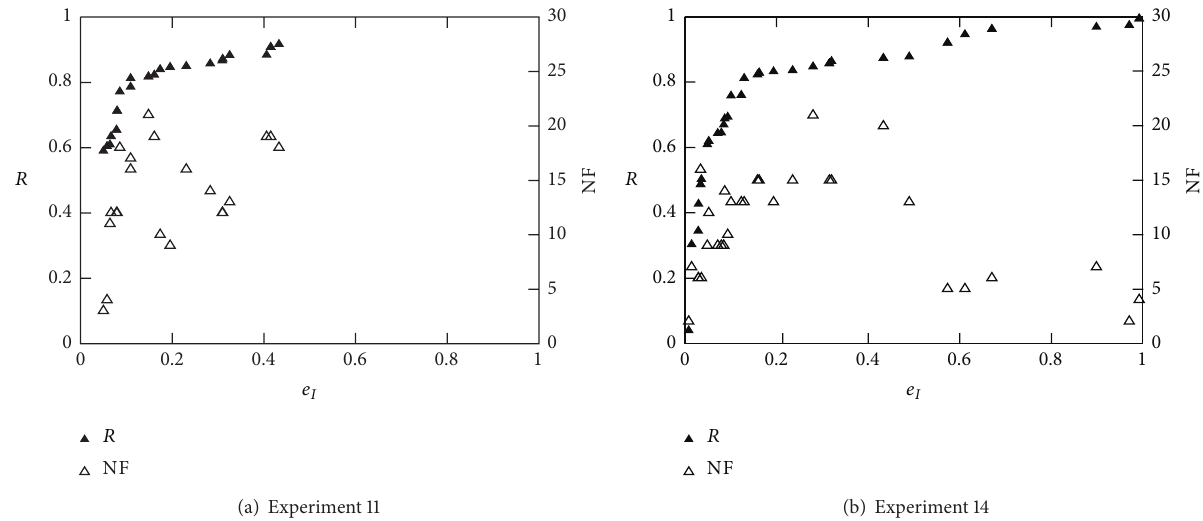
Figure 12: ROC curves for Diane 05 data (best of 10